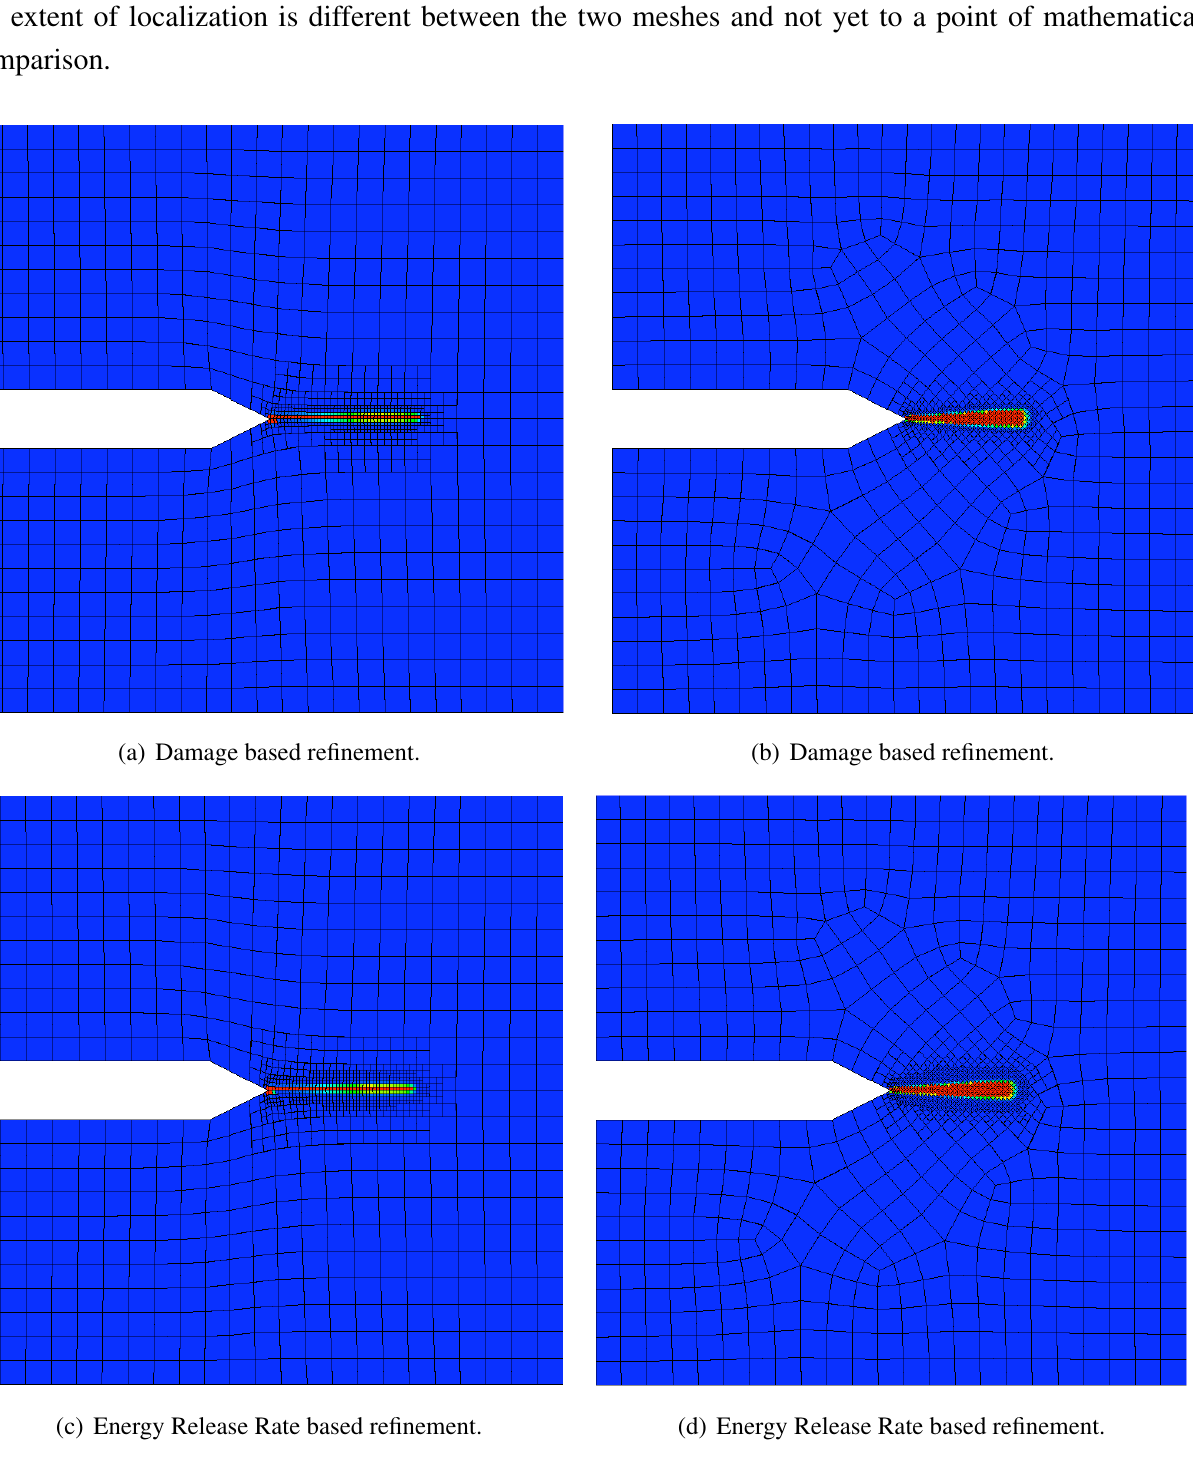
Figure 10 . Damage solutions on two very different meshes with the two proposed refinement